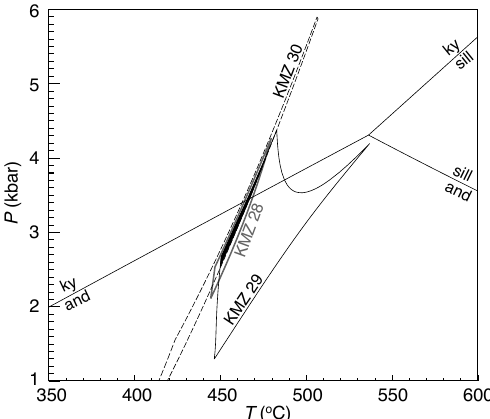
Figure 7. Summary of estimated P – T conditions for the KMZ, con- strained from the P – T overlap of the equilibrium assemblages that occur in the various mafic